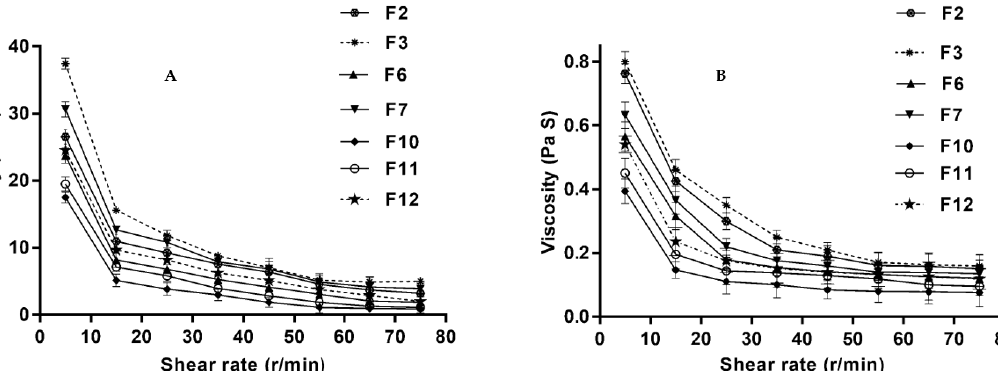
Figure 1. Rheological profiles of DEX in situ gel formulations at physiological ( A ) and non- physiological conditions ( B ).